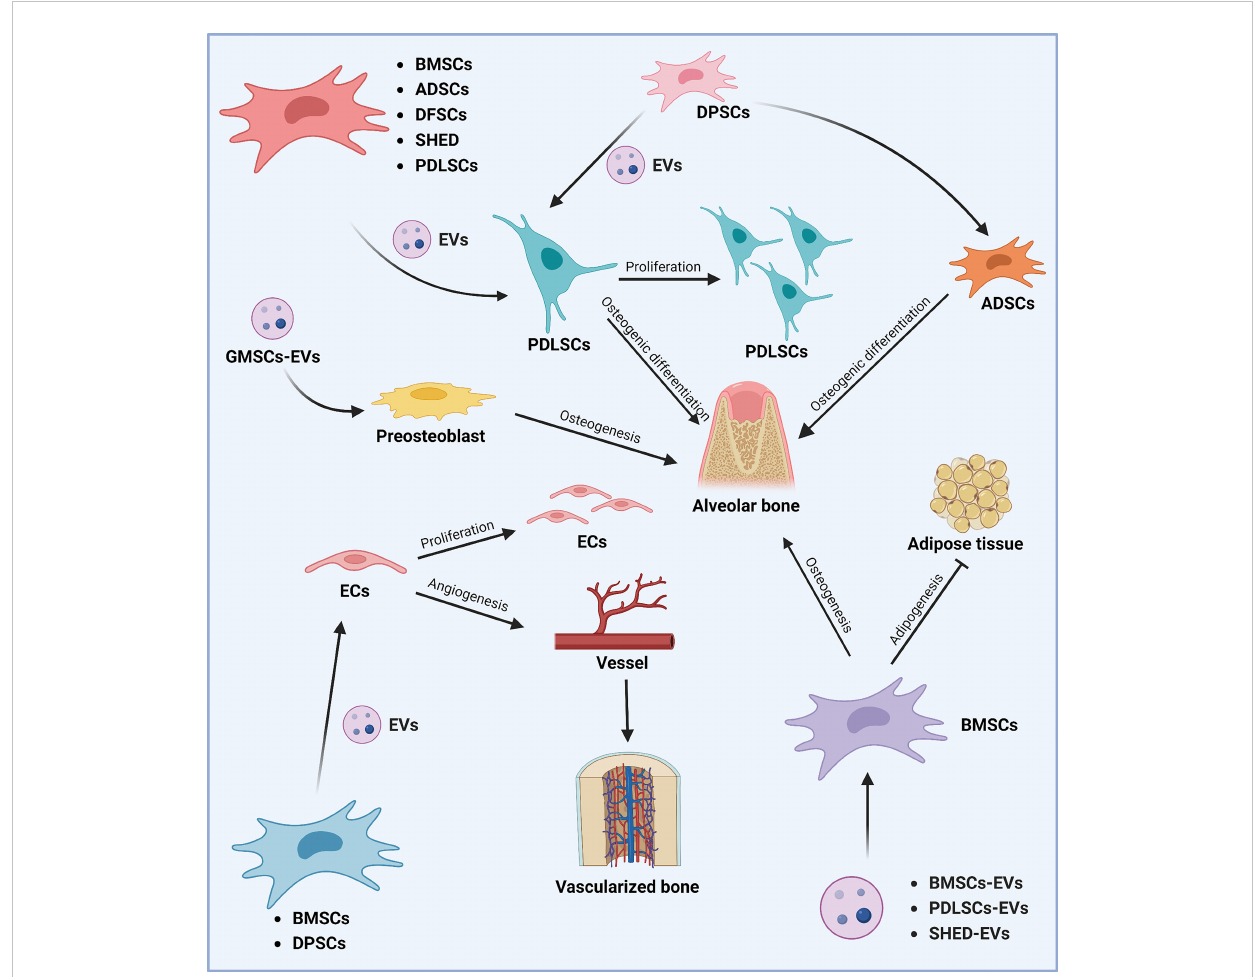
FIGURE 3 Role of stem cell-derived EVs in periodontal tissue regeneration. Different sources of MSCs can promote periodontal tissue regeneration and thus play a role in the treatment of periodontitis. Various sources of MSCs-EVs (including BMSCs, ADSCs, DFSCs, SHED, DPSCs, and PDLSCs) can promote the proliferation of periodontal membrane stem cells and alveolar bone osteogenesis by regulating osteogenic differentiation. DPSCs- derived EVs can promote alveolar bone regeneration by affecting the osteogenic differentiation of ADSCs. In addition, GMSCs-derived EVs can promote alveolar bone regeneration by regulating osteoblast precursor cells. In addition, BMSCs, PDLSCs, and SHED-derived EVs can promote osteogenic differentiation and inhibit lipogenic differentiation of BMSCs, thus promoting alveolar bone regeneration. The Graph was created with BioRender.com. BMSCs, bone marrow-derived mesenchymal stem cells; ADSCs, adipose tissue-derived mesenchymal stem cells; DFSCs, dental follicle stem cells; SHED, stem cells of human exfoliated deciduous teeth; PDLSCs, periodontal ligament stem cells; EVs, extracellular vesicles; GMSCs, gingiva-derived mesenchymal stem cells.